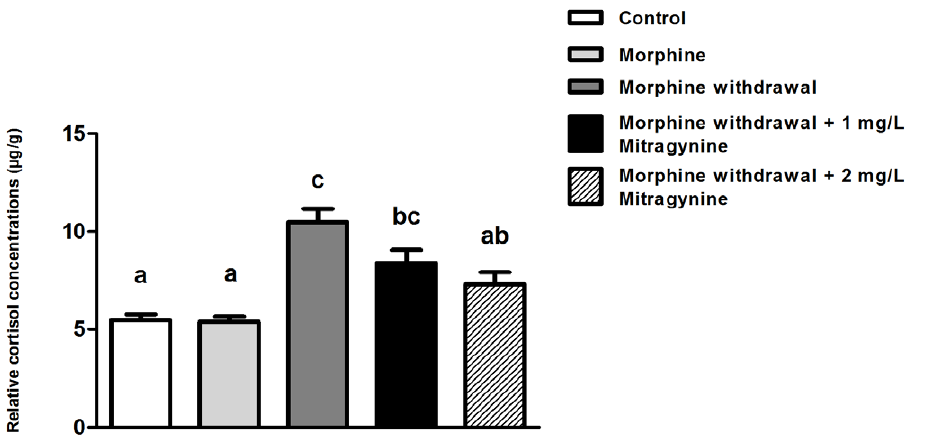
Figure 3. Effect of two weeks chronic morphine treatment (1.5 mg/L), 24-h morphine withdrawal and morphine withdrawal in presence of mitragynine (1 mg/L or 2 mg/L) on whole-body cortisol ( m g/g fish). Data are presented as mean 6 SEM. (Control, n=16; morphine treatments, n=14; morphine withdrawal, n=21; 1.0 mg/L Mitragynine, n=23; 2 mg/L Mitragynine, n=20). Mean values were subjected to one way ANOVA and where applicable, ranked by Tukey test (P , 0.05); values with same letter are not significantly different.